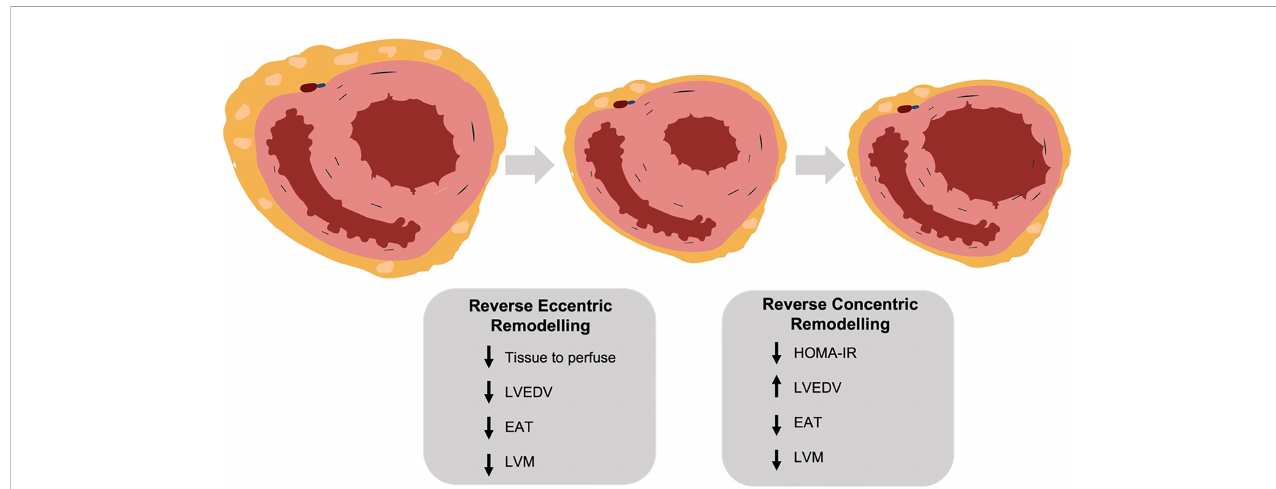
FIGURE 5 (central fi gure) – following bariatric surgery the left ventricle undergoes a biphasic remodelling response. Initially there is a reversal of eccentric remodelling as total body tissue to perfuse falls, with reductions in left ventricular mass, end diastolic volume and epicardial adipose tissue. In the longer term there is a reversal of concentric remodelling as insulin resistance (HOMA-IR) decreases, with a further fall in left ventricular mass but an increase in end diastolic volume. LVEDV, left ventricular end diastolic volume; EAT, epicardial adipose tissue; LVM, left ventricular mass; HOMA-IR, homeostatic model assessment of insulin resistance. Created with